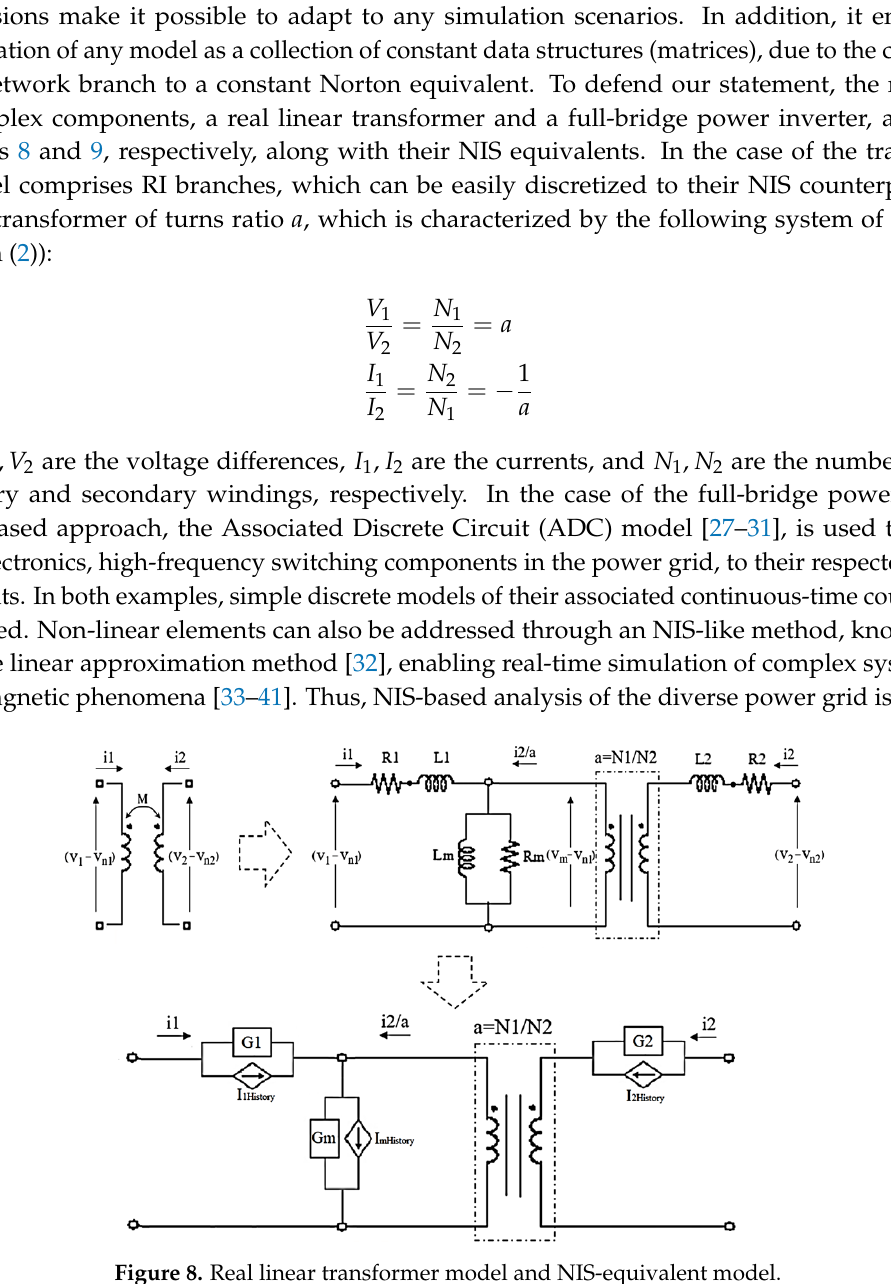
Figure 8. Real linear transformer model and NIS-equivalent